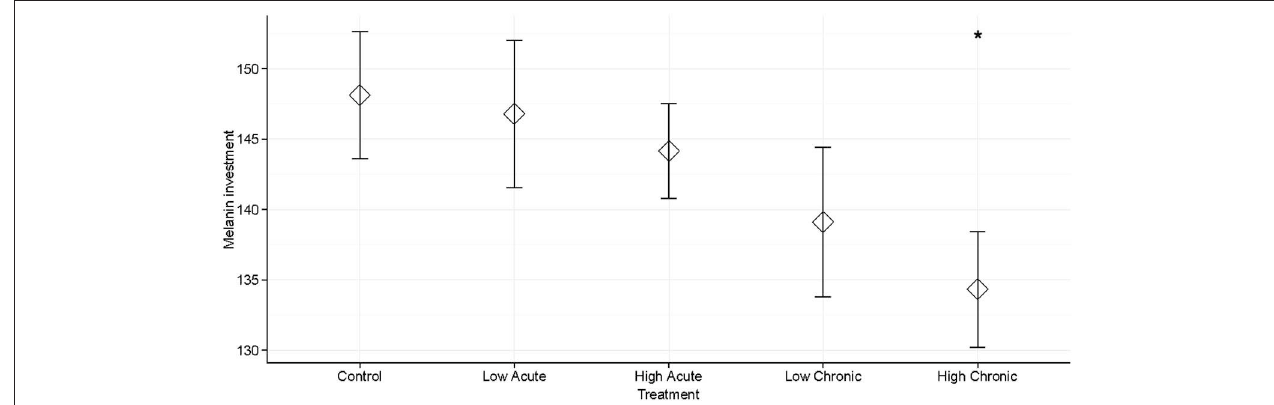
FIGURE 1 | Mean melanization of monofilaments for Anax junius dragonfly larvae across five deicing salt stress treatments: control (no added salt treatment); low concentration, acute exposure; low concentration, chronic exposure; high concentration, acute exposure; high concentration, chronic exposure. Error bars show the standard error around the mean. Melanization was significantly decreased in the High Chronic treatment compared to the control treatment (* P <